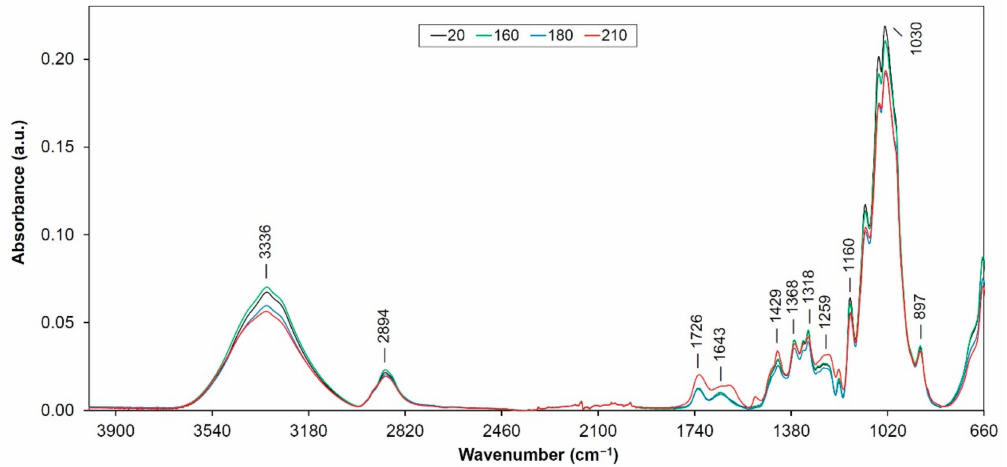
Figure 3. FTIR spectra of the thermally treated cellulose from oak